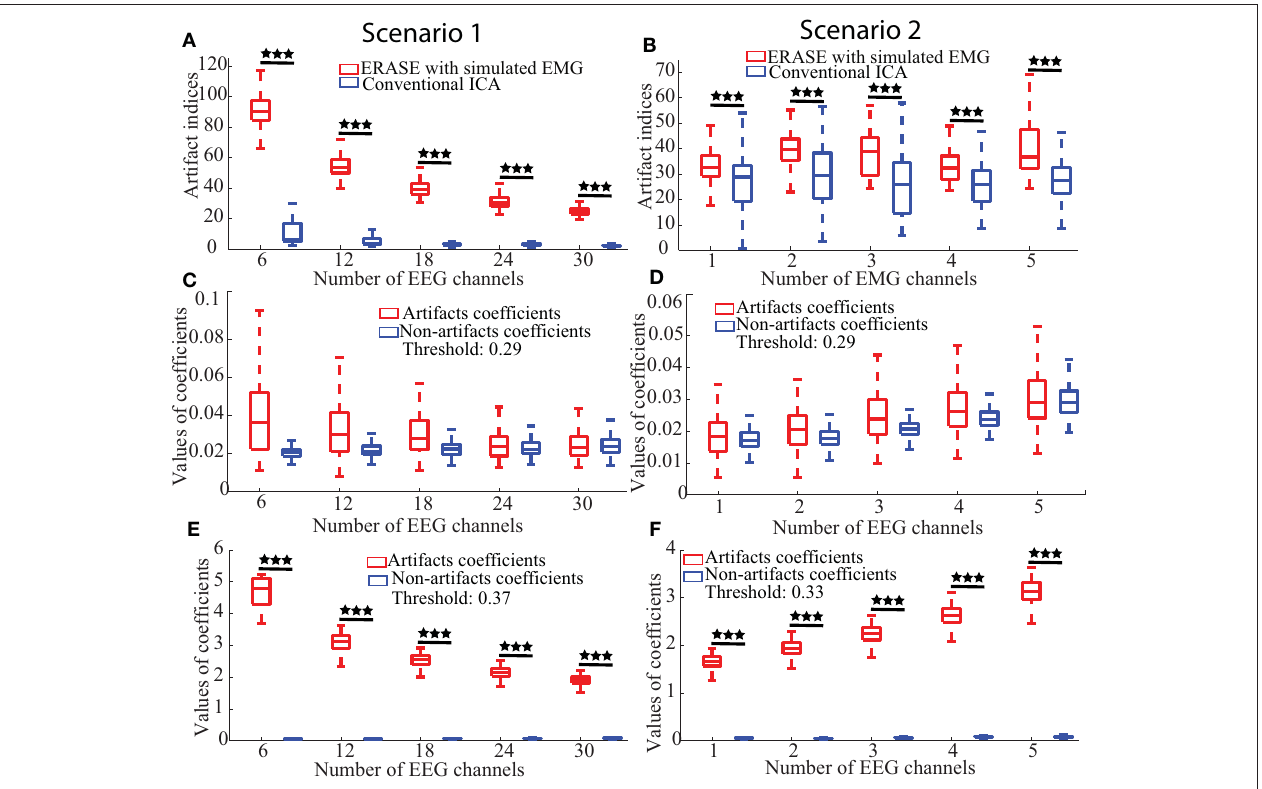
FIGURE 2 | Effectiveness, false positive, and sensitivity of ERASE on the simulated data. (A,B) Artifact indices, i.e., effectiveness in Scenario 1 and 2, respectively. (C,D) False positive for Scenario 1 and 2, respectively. (E,F) Sensitivity results for Scenario 1 and 2, respectively. Scenario 1 was considered as the fact that the number of contaminated EEG was changed for the performance assessment of ERASE. Here, the number of contaminated EEG channels were chosen from 2 to 10 for each simulated EMG artifacts (three EMG artifacts were used here, so numbers are 6–30 in figures). We increased the number of added EMG channels in Scenario 2 for the performance assessment of ERASE. The number of added EMG channel was chosen from 1 to 5. Asterisks indicate a significant difference between two data sets (Wilcoxon Rank-Sum Test), and the significance level = *** p <